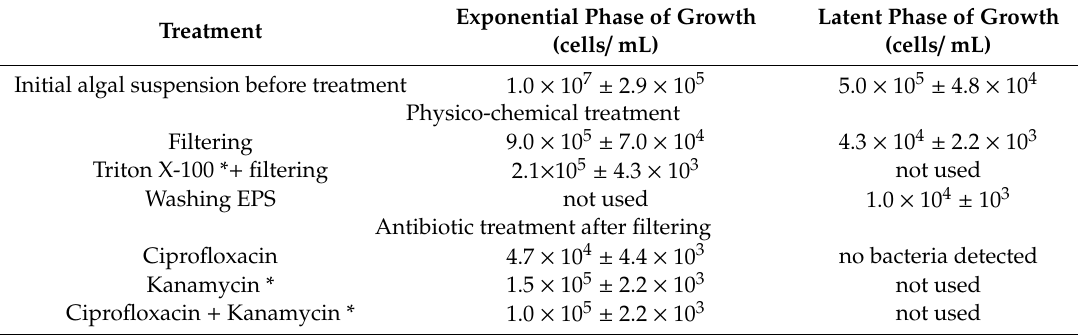
Table 1. Total number of bacteria associated with U. danica before and after physico-chemical and antibiotic